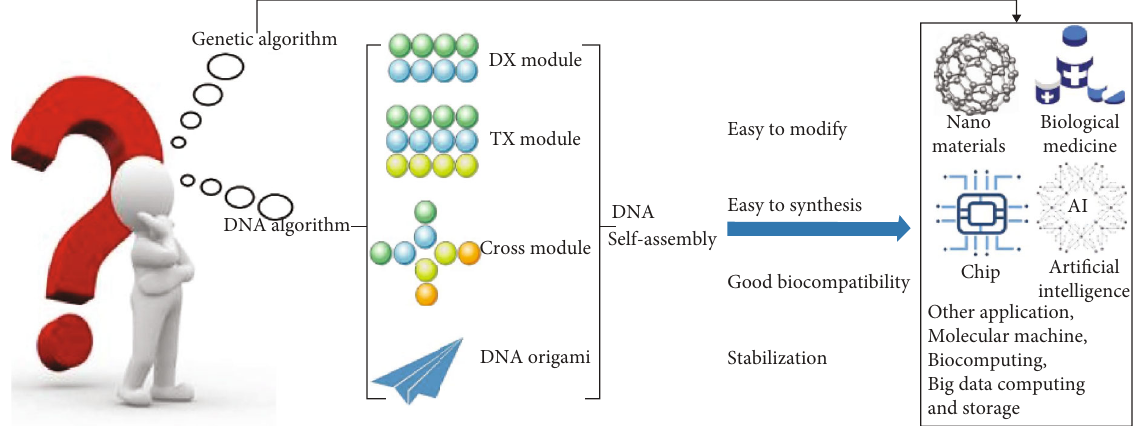
Figure 2: The process and characteristics of applying DNA algorithm and genetic algorithm to nanomaterials, biomedical medicine, chip, arti fi cial intelligence, and other